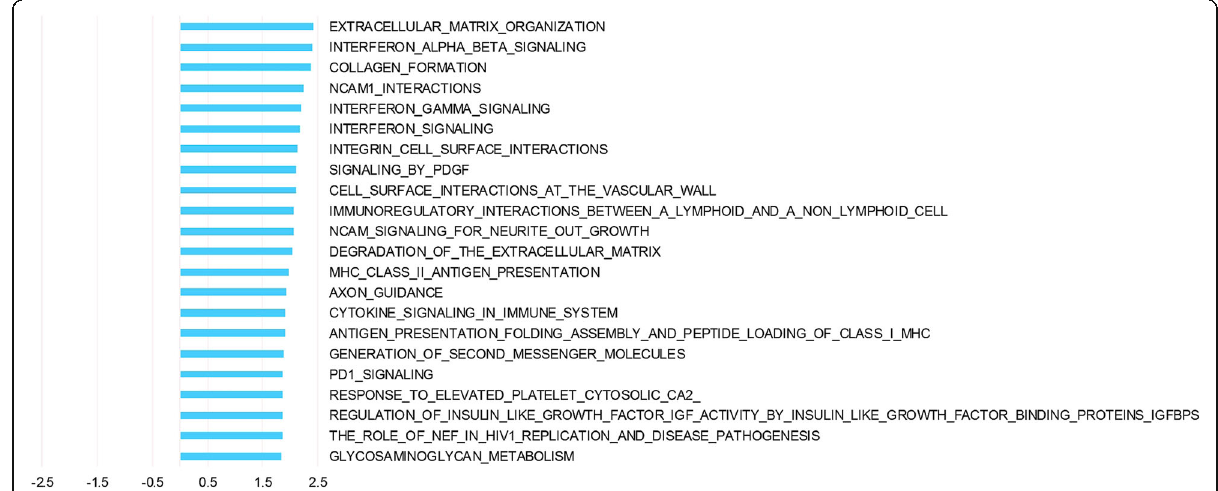
Fig. 4 Pathway analysis of the effect of tissue type. Pathway analysis was performed with GSEA using ranking of genes according to the tissue term from GEE. NES depicted for all Reactome pathways significantly altered in tumor samples compared to normal samples irrespective of whether samples were collected pre- or